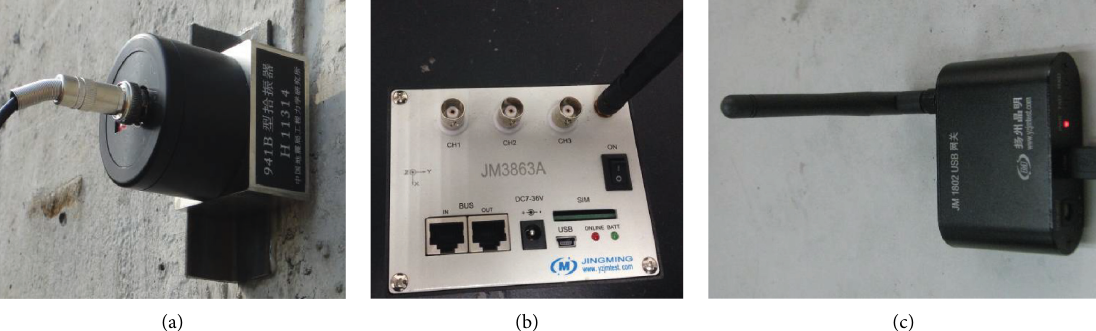
Figure 2: Sensors, signal collecting system, and signal transmission system of vibration tests. (a) 941B sensor. (b) JM3863A vibration test system. (c) JM1802 wireless gateway.